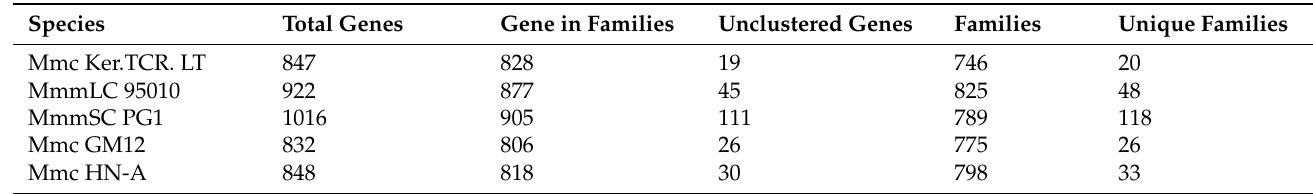
Table 5. Gene family analysis of five Mycoplasma mycoides